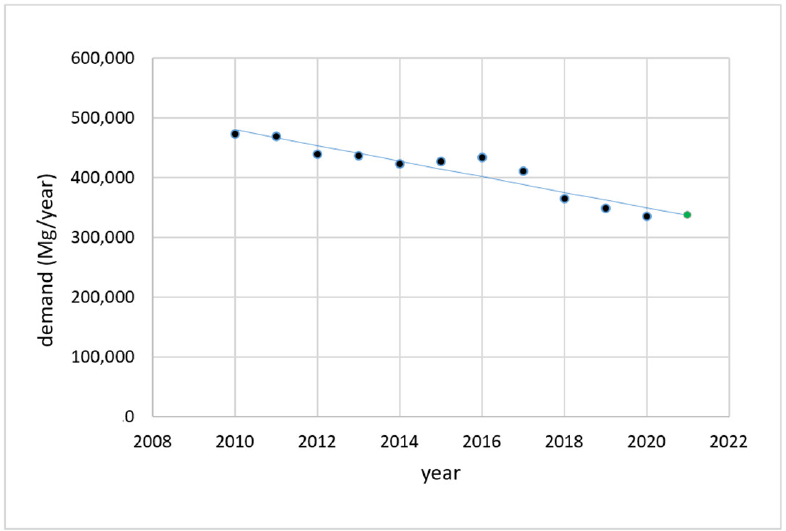
Figure 3. Demand of the “Indv. consumers 1” group in the years 2010–2020 with the forecast for 2021.